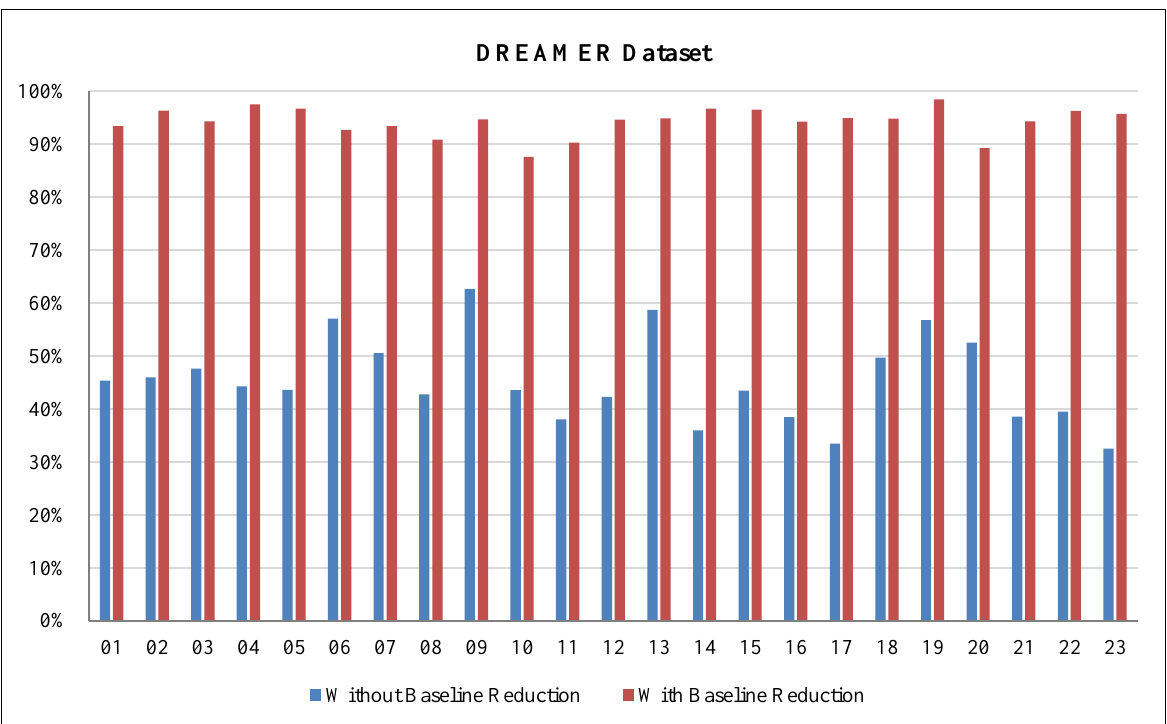
Figure 9. Comparison of accuracy with and without baseline reduction approach on the DEAP dataset